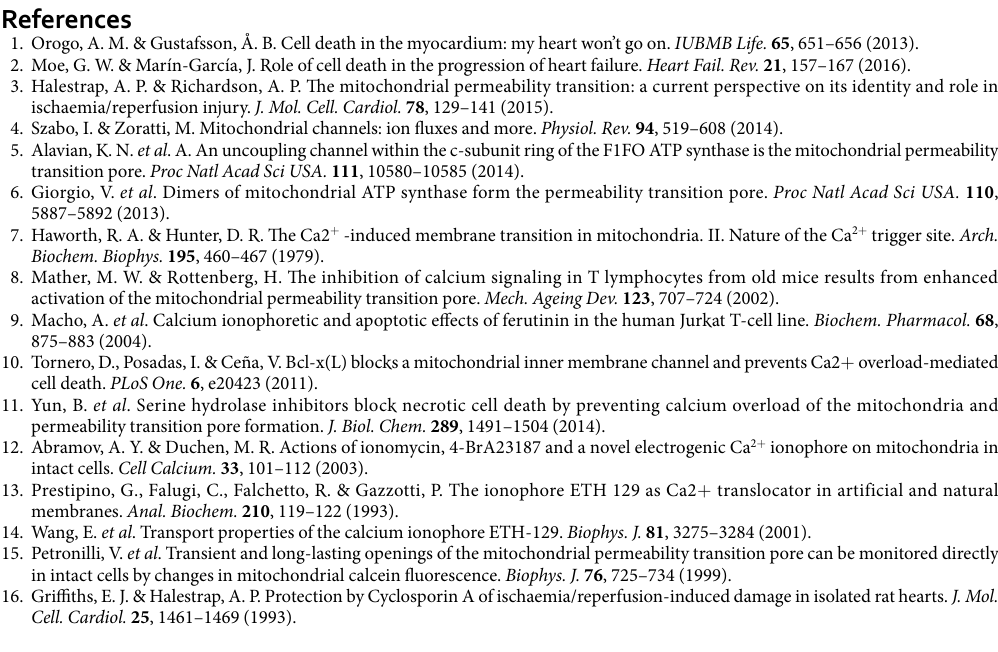
For each experiment, the change of fluorescence was observed from a single cardiomyocyte and then, the global response was analysed by averaging the fluorescence changes obtained from all the cardiomyocytes (at least 30 cells) contained in a single field. In hypoxia-reoxygenation experiments, the time of reoxygenation nec- essary to induce a 50% decrease in calcein fluorescence (time to 50% mPTP opening [T mPTP50 ]) and to induce a 50% increase in propidium iodide fluorescence (time to 50% cell death [T cell death50 ]) were determined. When cell contracture was evaluated, cells were considered hypercontracted when they exhibited an irreversible loss of the rod-like shape (Fig. 6a). Hypercontracture was expressed as the percentage of contractured cells over the total cells on the field. Hypoxia-reoxygenation model. Mouse cardiomyocytes were placed into a thermostated (37 °C) cham- ber (Warner Instruments Inc, Connecticut) which was mounted on the stage of an IX81 Olympus microscope (Olympus, Rungis, France) and were perfused with the Tyrode’s solution at a rate of 0.5 ml/min. The chamber was connected to a gas bottle diffusing a constant stream of O 2 (21%), N 2 (74%) and CO 2 (5%) maintaining an O 2 concentration of 21%. Oxygen in the perfusate was measured in the chamber using a fibre optic sensor system (Ocean Optics Inc., Florida). Cardiomyocytes were paced to beat by field stimulation (5 ms, 0.5 Hz). To simulate ischaemia, the perfusion was stopped and cardiomyocytes exposed for 45 or 90 min to a hypoxic medium maintaining an O 2 concentration of 1–2%. This medium was the Tyrode’s solution (bubbled with 100% N 2 ) supplemented with 20 mM 2-deoxyglucose and subjected to a constant stream of N 2 (100%). At the end of the ischemic period, reoxygenation was induced by rapidly restoring the Tyrode’s flow and 21% O 2 in the chamber (Fig. 7b).